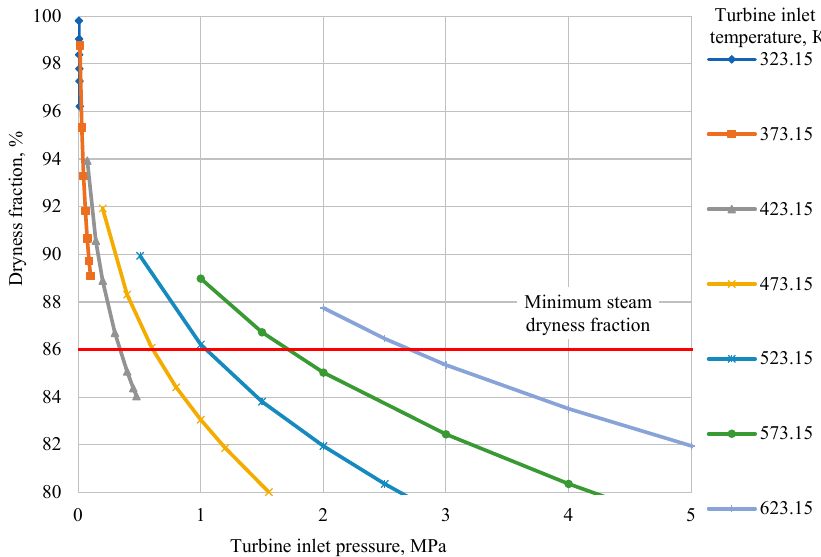
Figure 9. Turbine outlet dryness fraction dependence on inlet parameters for simple steam cycle. Figure 10 illustrates the simple Rankine cycle analysis example. It shows the efficiency dependence on the initial temperature and pressure for the R124 heat carrier. At the sub-critical initial temperature, maximal efficiency is reached at the turbine inlet pressure equal to the saturation pressure. When the initial temperature is supercritical, the optimal initial pressure is considerably higher and reaches 31 MPa at the maximal allowable temperature of 573 K. This is due to the increase in pump- and turbine-specific power with the increase in initial pressure, which leads to the optimum at the supercritical initial parameters. The dependence of the Rankine cycle efficiency on initial temperature and pressure was calculated for the remaining selected working fluids in a similar way. Figure 10. Simple Rankine cycle efficiency for R124 and different inlet temperatures and pressures. Figure 11 shows optimal initial pressures for different working fluids and initial temperatures. Water has the smallest initial pressure at all initial temperatures. The